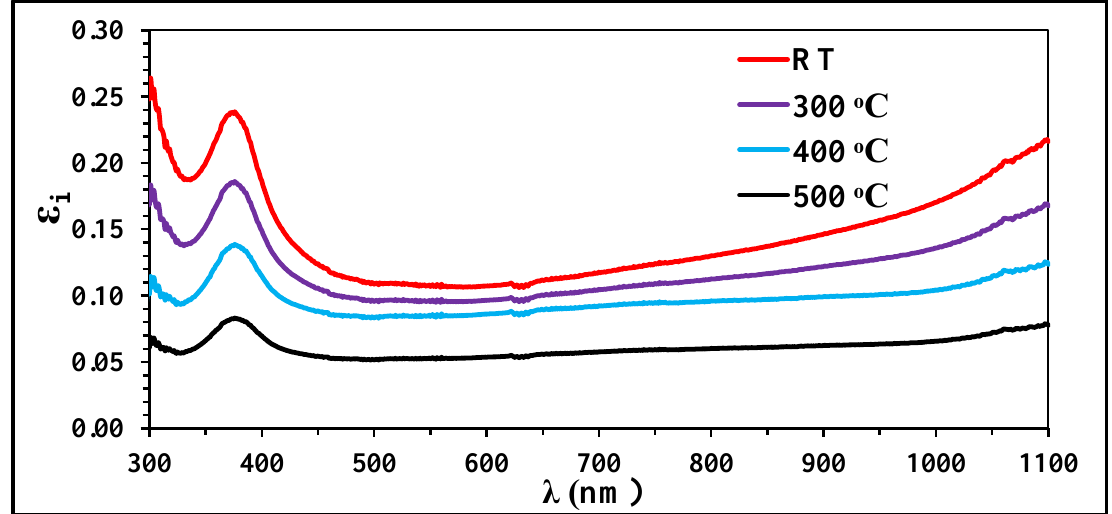
Fig. 11: The imaginary part of dielectric constant of the Cr